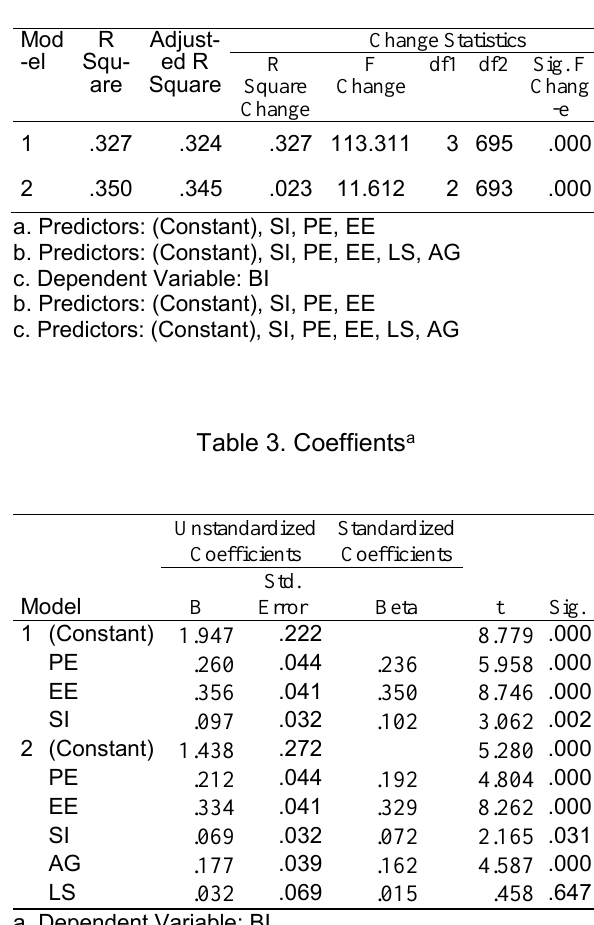
Table 2. Model Summary